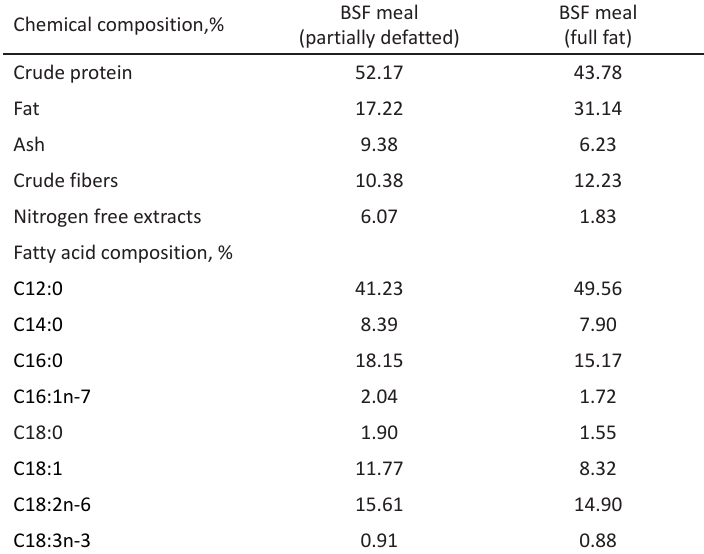
Table 3. Chemical and fatty acid composition of the BSF meals included in the